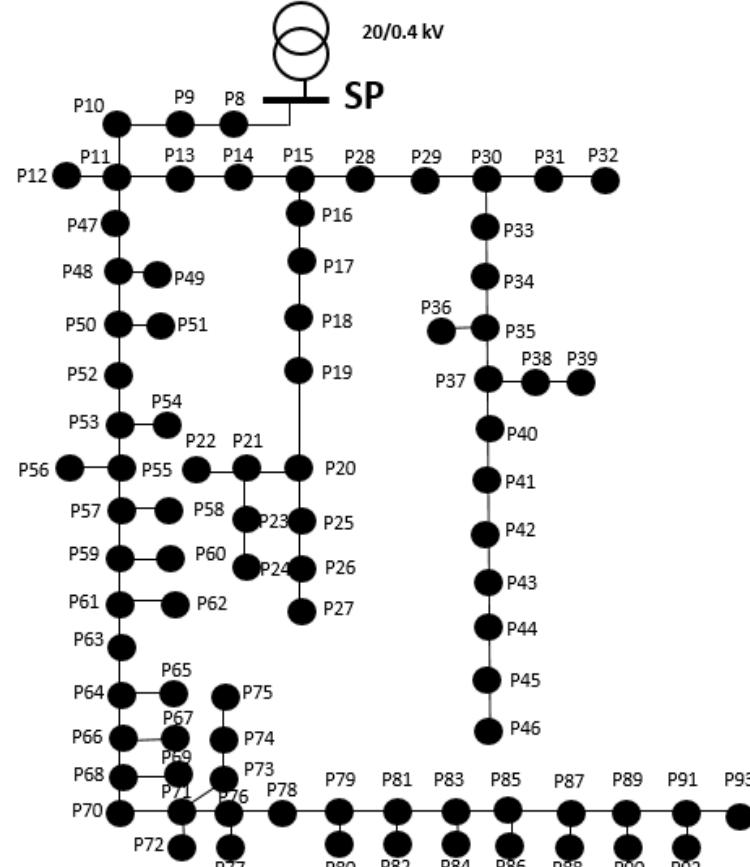
Figure 8. The structure of analyzed electric distribution networks (EDN). Table 4. The technical characteristics of the branches.